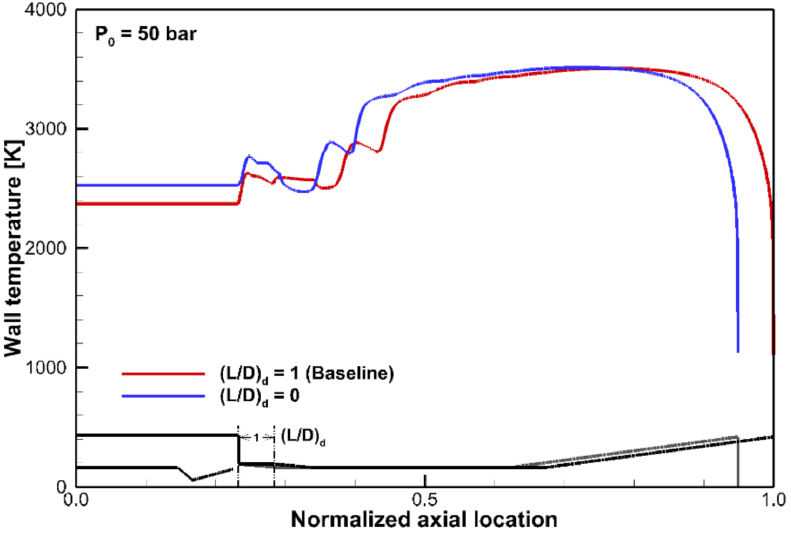
Figure 10. Wall temperatures of two diffuser entrance length